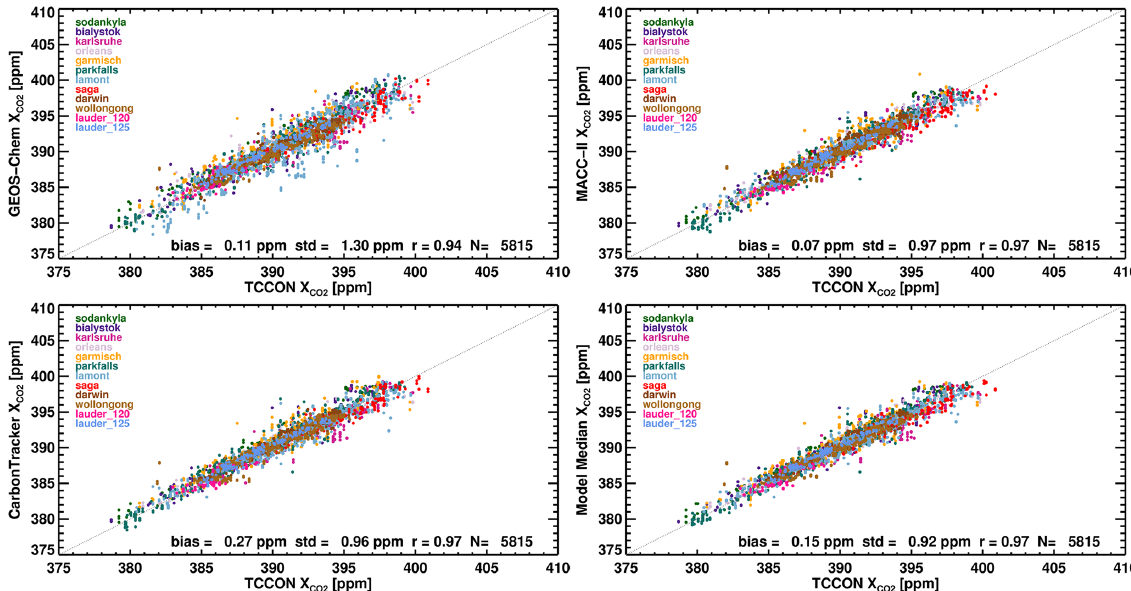
Figure 4. Correlation plot of the model XCO 2 data for GEOS-Chem, MACC-II, CarbonTracker, and the ensemble median against TCCON ground-based FTS data at 11 TCCON sites. The overall bias, standard deviation (single-measurement precision), correlation coefficient, and total number of soundings are provided